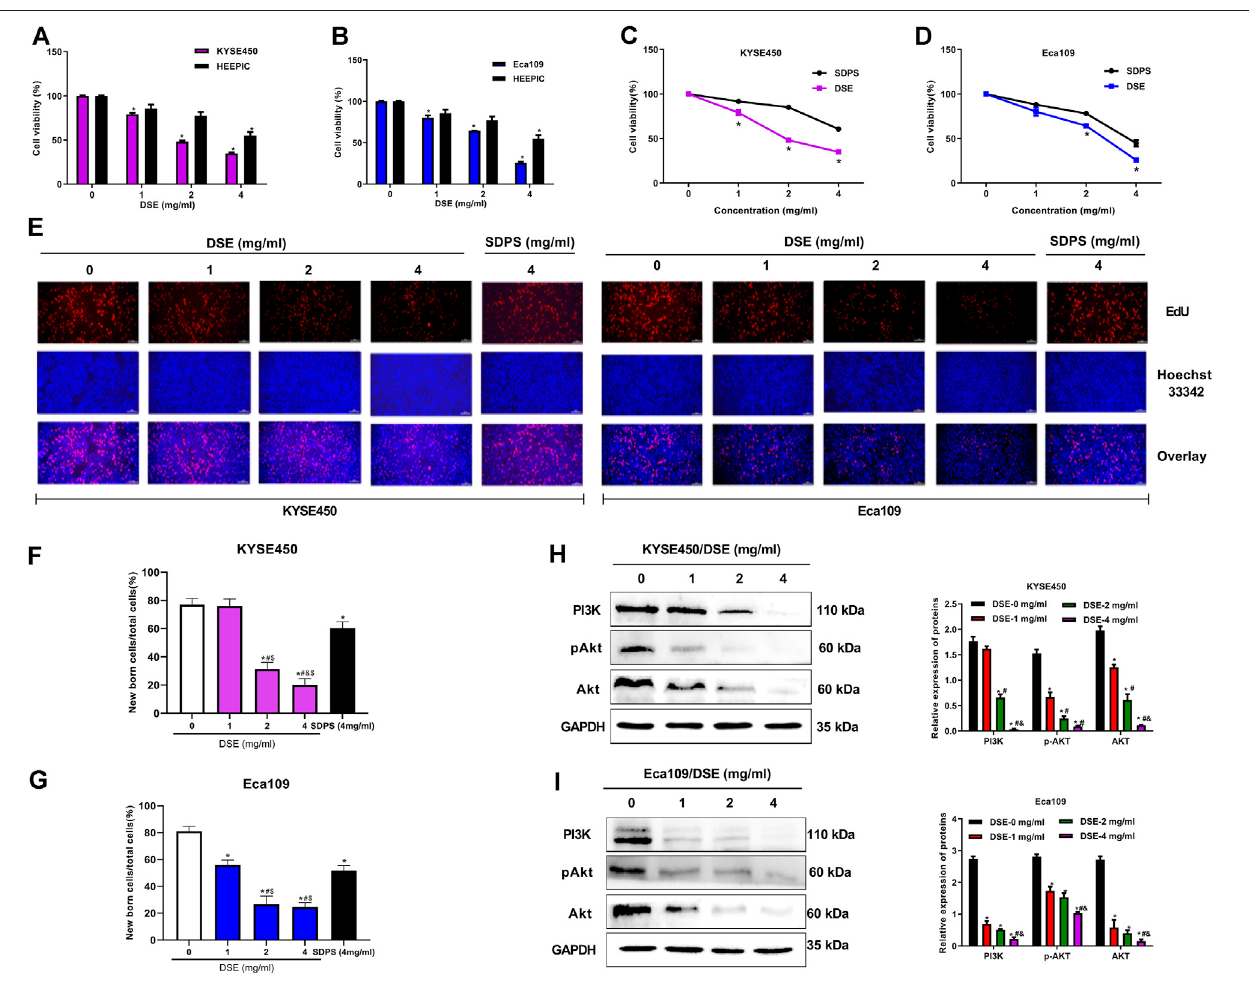
FIGURE 2 | DSE suppresses cell proliferation and inhibits PI3K/Akt pathway in human ESCC cells. (A,B) DSE on cell viability in KYSE450, Eca109 and normal esophageal epithelial HEEPIC cells. All data are expressed as mean ± standard deviation ( n = 3). * p < 0.05 vs. 0 mg/ml DSE group. (C,D) Effects of DSE and positive control SDPS on cell viability in KYSE450 and Eca109 cells. All data are expressed as mean ± standard deviation ( n = 3). * p < 0.05 vs. SDPS group. SDPS: shidaopingsan. (E – G) Effects of DSE on cell proliferation in KYSE450 and Eca109 cells. Representative images were taken. Scale bars, 100 µm. All data are expressedasmean±standarddeviation(n=3).* p < 0.05vs.0 mg/mlDSEgroup. # p < 0.05vs.1 mg/mlDSEgroup. & p < 0.05vs.2 mg/mlgroup. $ p <